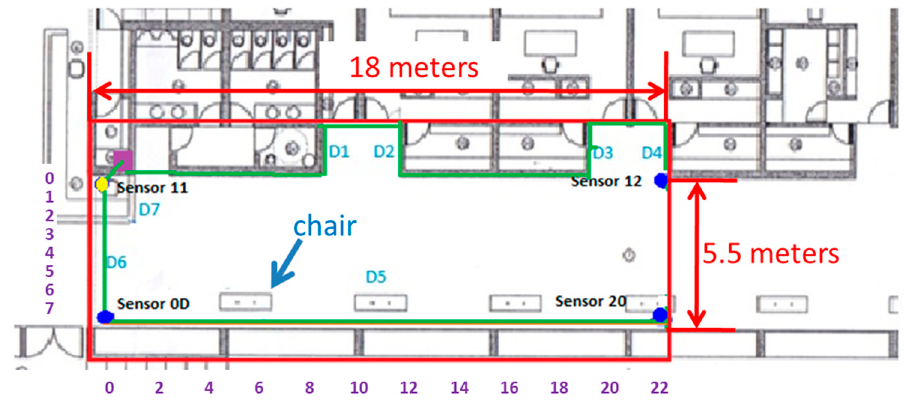
Figure 6. Map of the real scenario and the deployment of the devices.